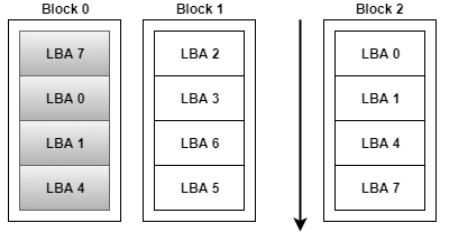
Figure 1.2. Write pattern (0-1-4-7) is applied,